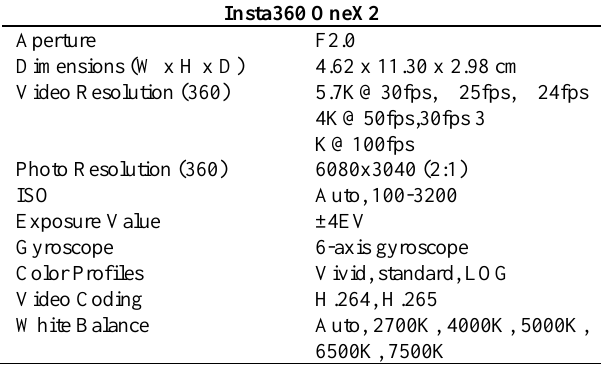
Table 2 . Technical features of Insta360 OneX2.